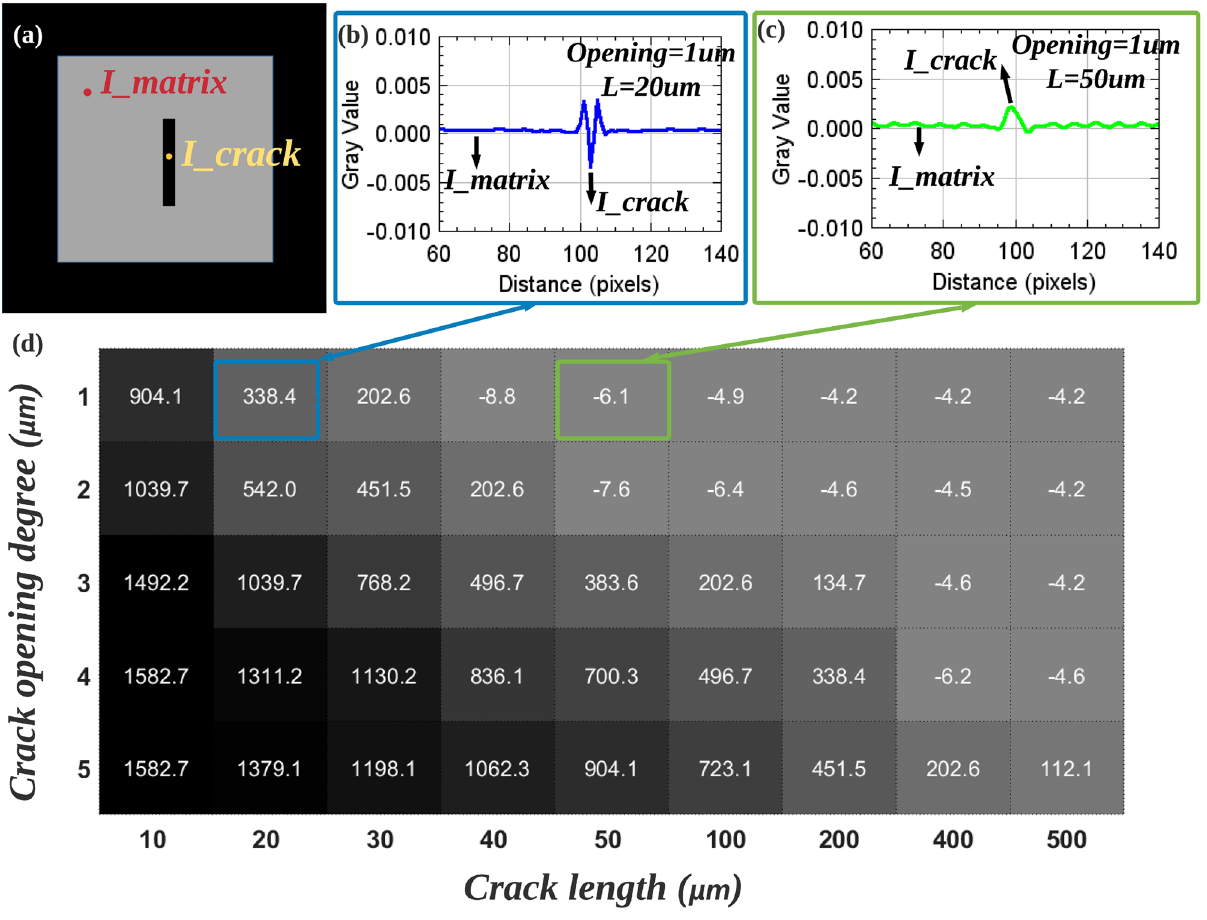
Figure 5. Normalized contrast of cracks with different length/opening in reconstructed images (see Fig. 2 for a definition of the crack geometry). Cracks contrasts are normalized by using the difference between the gray value of the crack center ( I crack ) and that of the gray value of the matrix ( I matrix ), divided by the gray value of the matrix (Eq. 1). ( a ) Horizontal cross-section of scanned specimen, black represents air, gray represents AlSi matrix; ( b , c ) Gray value distribution along a profile taken at the center of the crack (opening = 1 µ m length = 20 µ m/50 µ m) in the reconstructed image; ( d ) Table of the normalized contrast, the darker the gray- level in the cell, the easier the cracks are to observe (see the text for